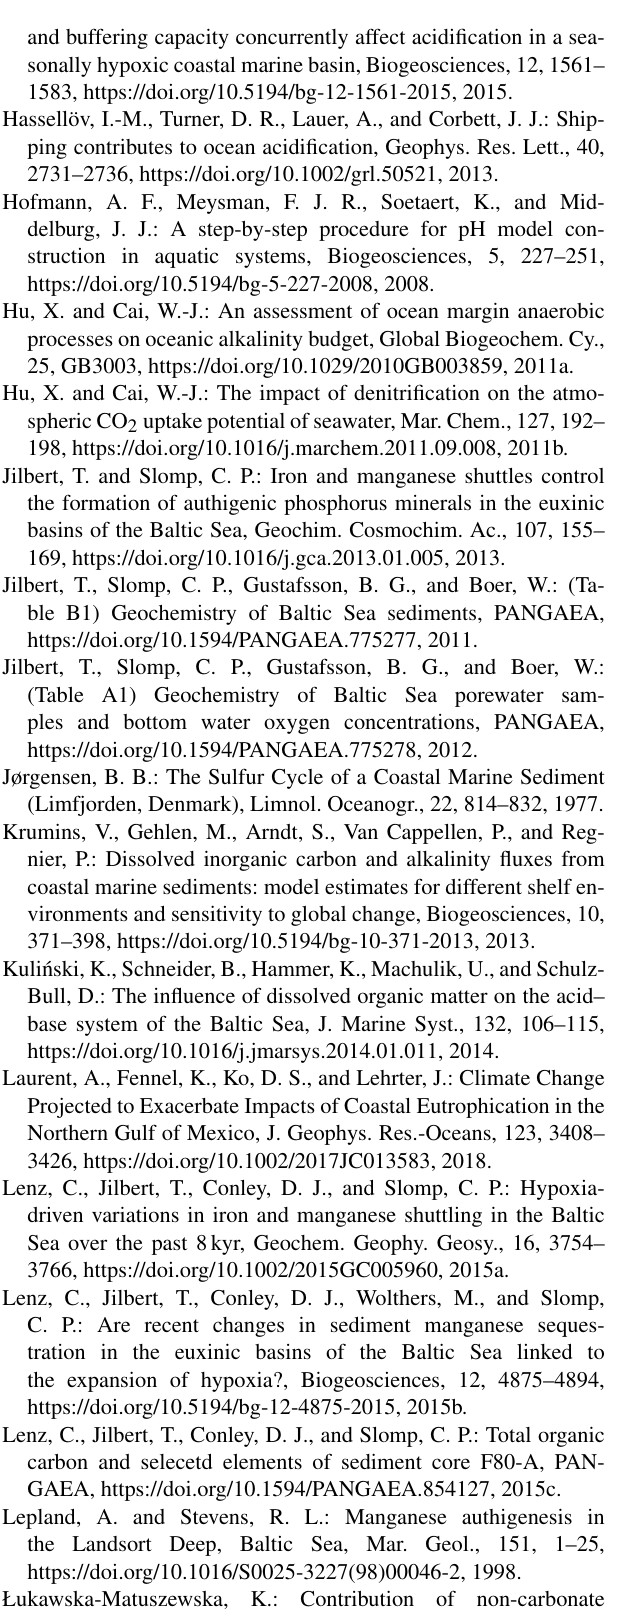
(Table A1) Geochemistry of Baltic Sea porewater sam- ples and bottom water oxygen concentrations,